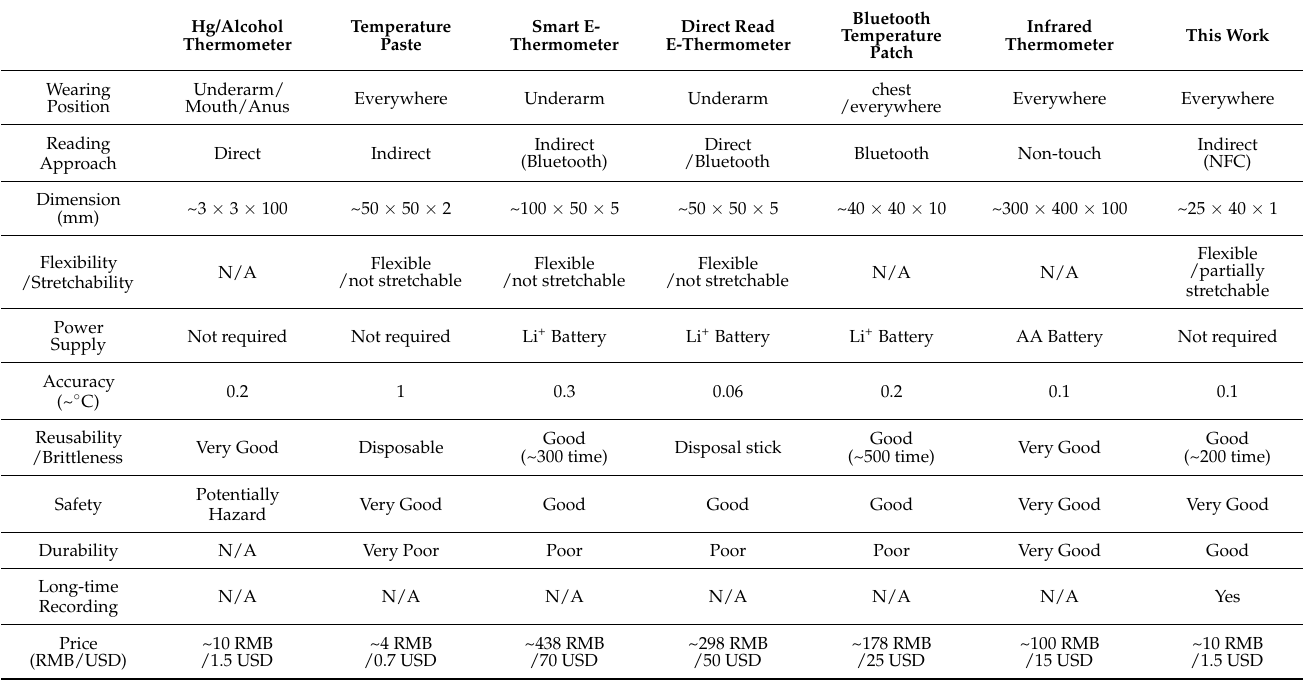
Table 1. Comparison of various types of thermometers